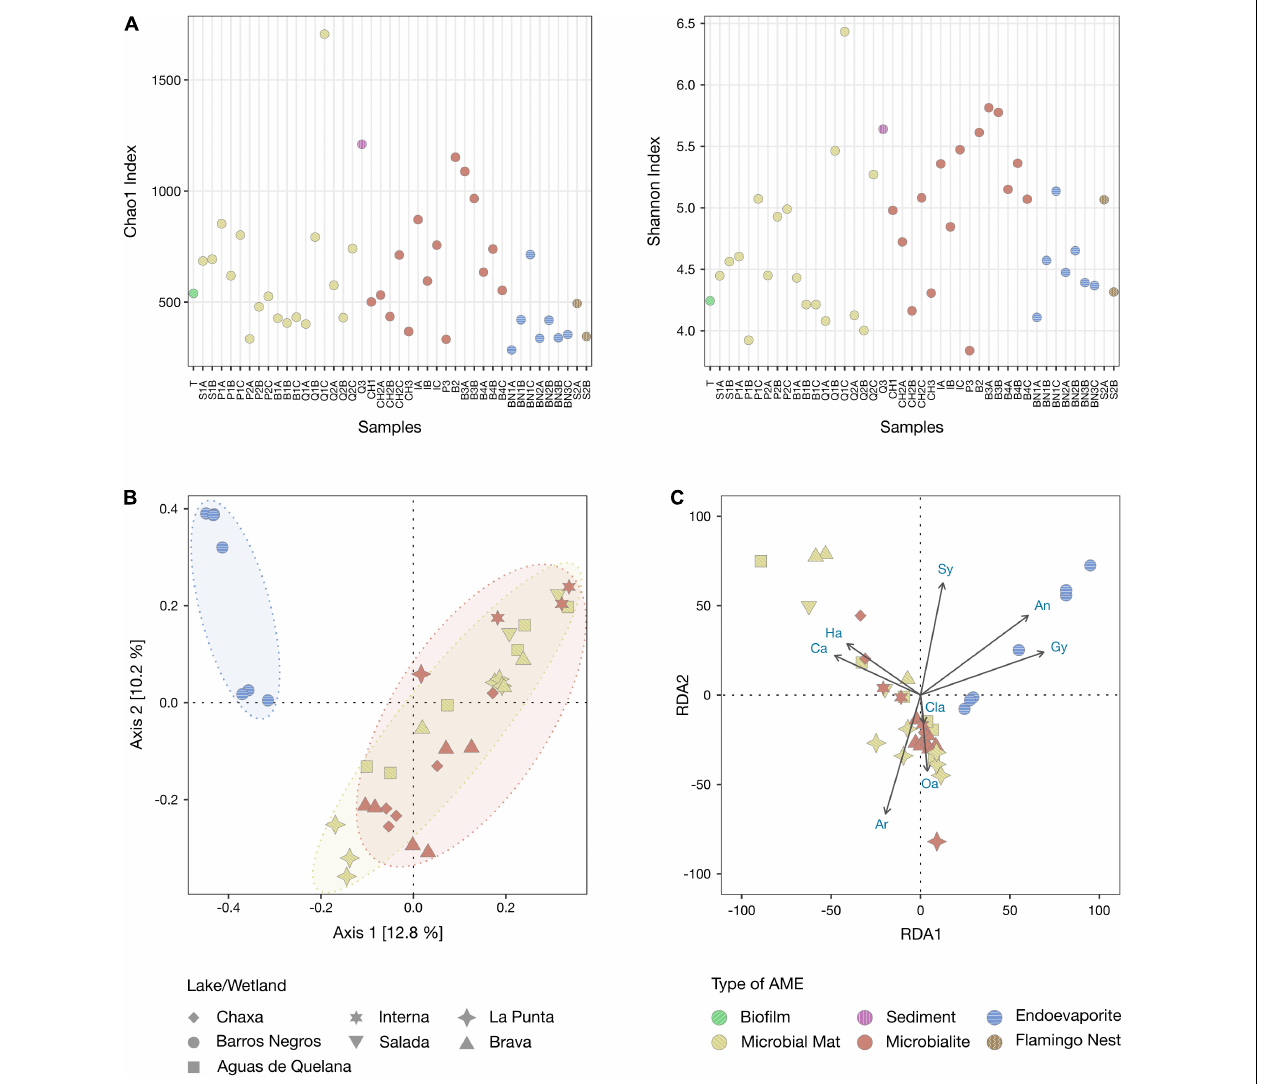
FIGURE 6 | Diversity analyses of the AMEs. (A) Comparison of alpha diversity metrics between samples. Left, richness estimates (Chao1 index) for the different samples. Right, diversity estimates (Shannon index) for the different samples. (B) Principal coordinate analysis (PCoA) based on Bray-Curtis dissimilarity between endoevaporite, microbial mat, and microbialite samples. (C) Redundancy analysis (RDA) of the relationship between minerals and endoevaporite, microbial mat, and microbialite samples. Arrows indicate the direction and magnitude of minerals associated with the samples. Ha, Halite; Ca, Calcite; Ar, Aragonite; Oa, Opal-A; Cla, Clay; Gy, Gypsum; An, Anhydrite; Sy,